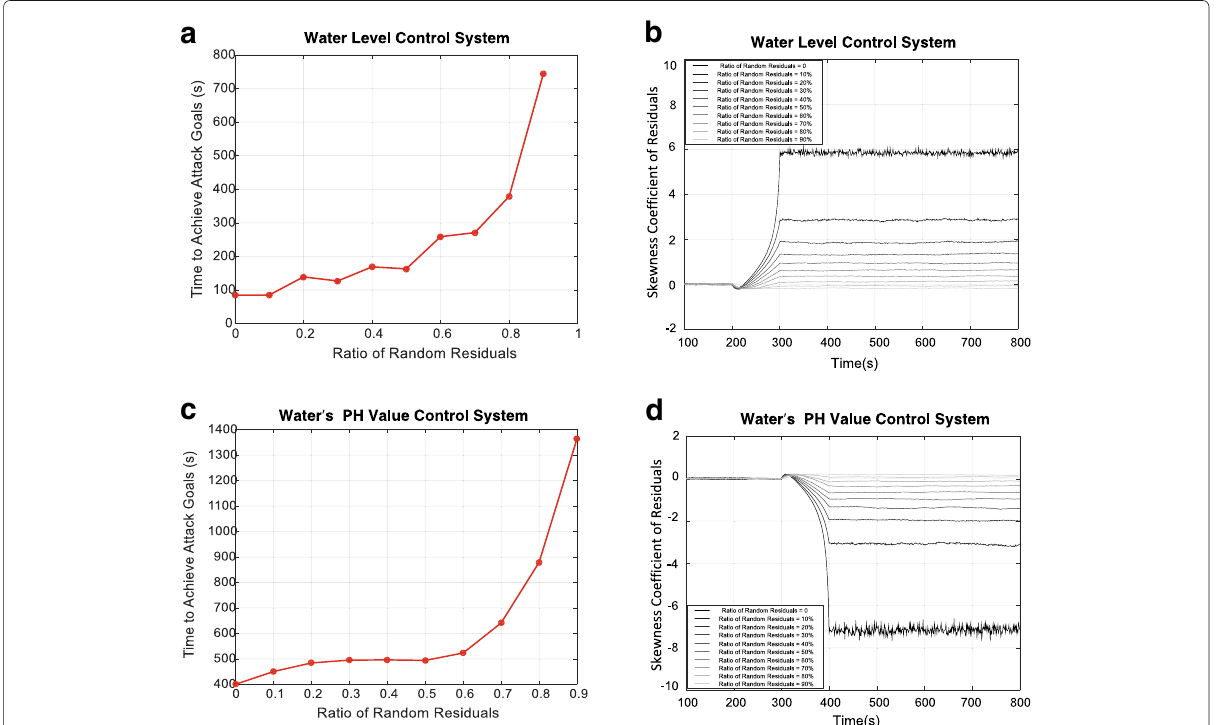
Fig. 10 Impacts of the ratio of random residuals on attack time and detection ability. Time to achieve attack goals becomes longer as the ratio of random residuals increases in the water level control system ( a ) and the pH value control system ( c ). Additionally, when the ratio of random residuals increases, the change of skewness Coefficient of residuals becomes more subtle, as shown in ( b ) and ( d )